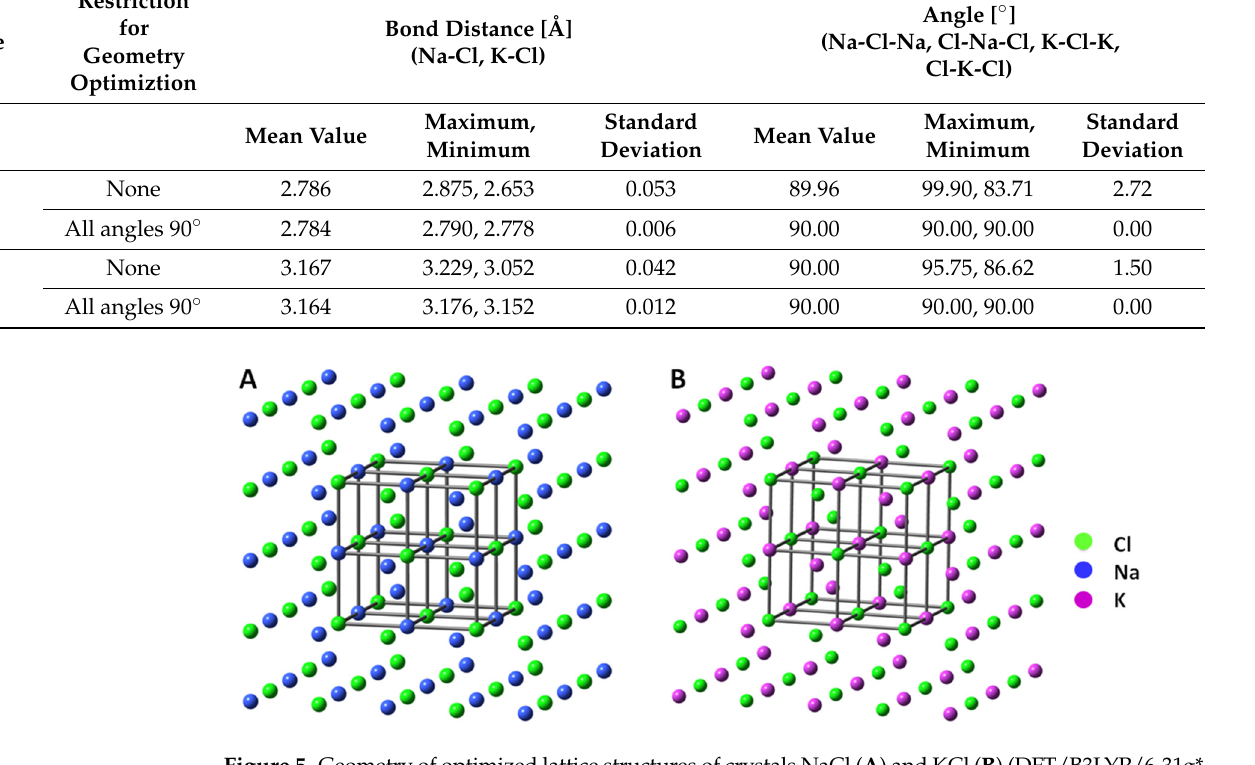
Figure 5. Geometry of optimized lattice structures of crystals NaCl ( A ) and KCl ( B ) (DFT/B3LYP/6-31g*, all angles equal 90 ◦ , 125-atom Table 4. Comparison of calculated geometric parameters for NaCl and KCl models of crystal structures (125 atoms) for calculation at the DFT/B3LYP level of theory with 6-31g* basis set.